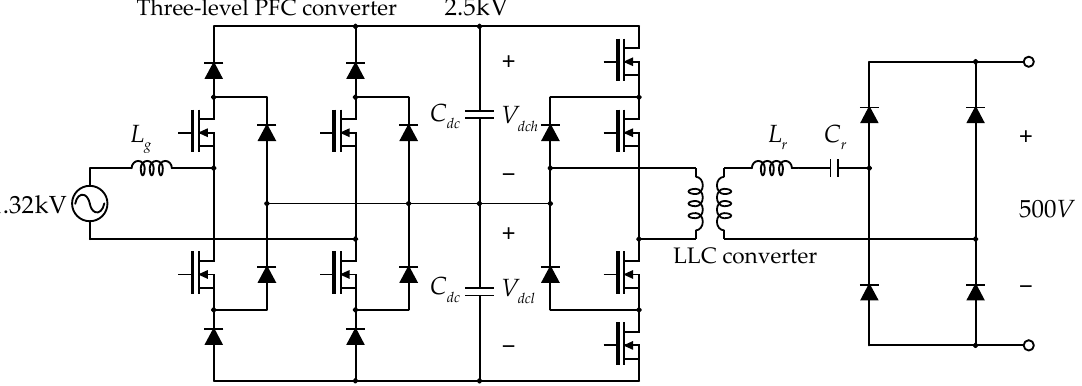
Figure 3. Circuit configuration of the 1.32 kV/1 kVA module. PFC: power factor correction.